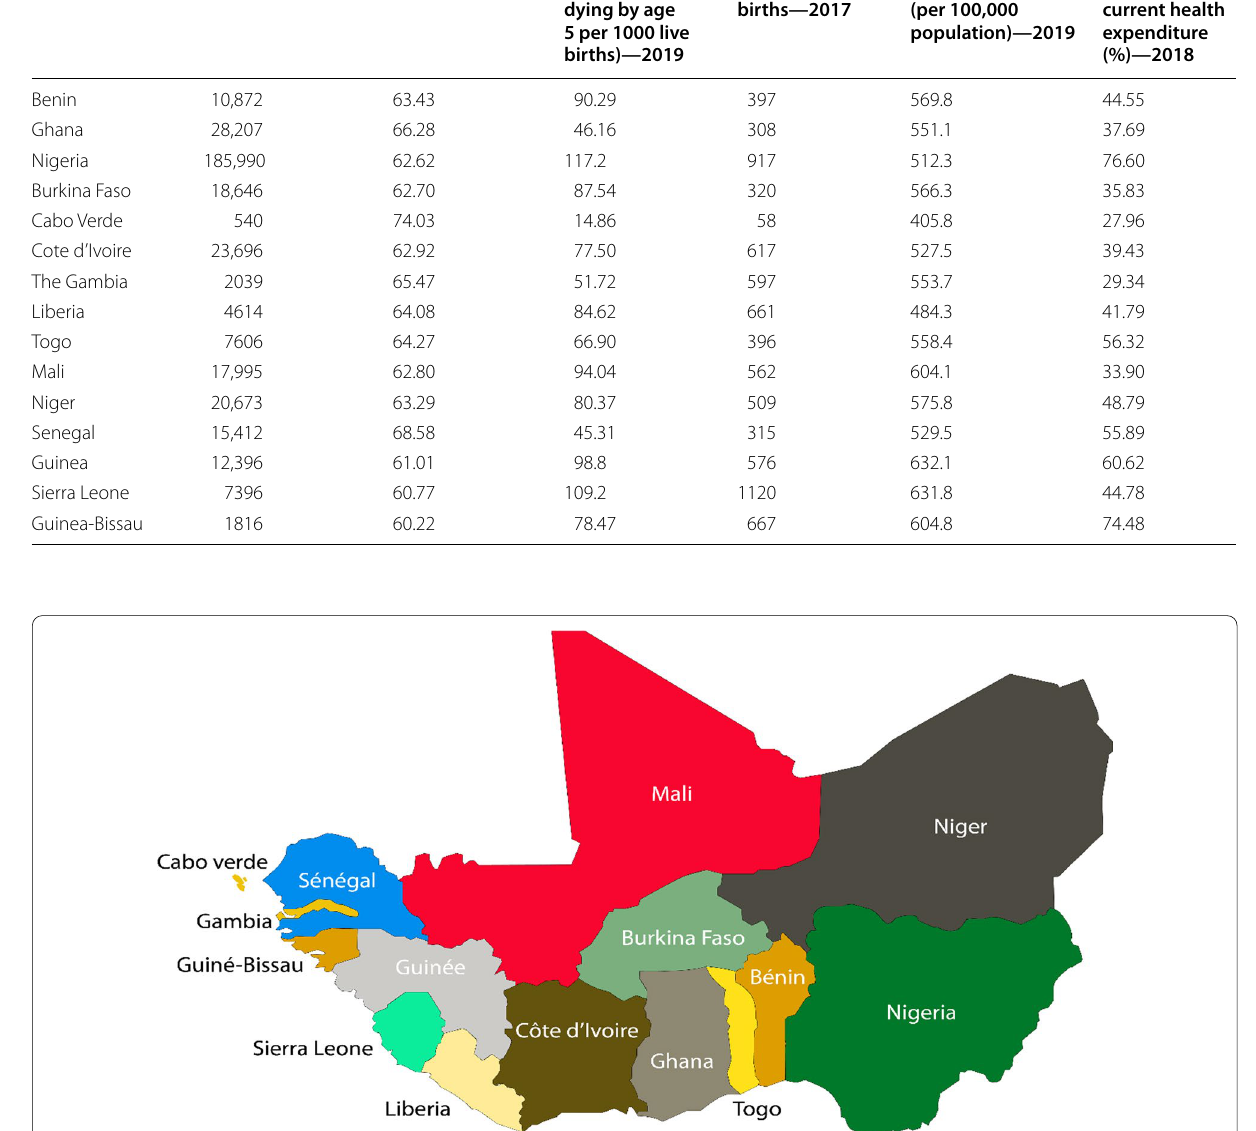
Table 1 Total population and selected health indicators in ECOWAS. Source: Authors compilation from Global Health Observatory Database. Accessed link: https:// www. who. int/ data/ gho/ data/ indic ators Accessed 29 Sept 2021 Country/Indicator Total population (in